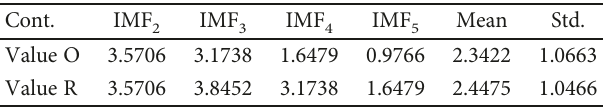
Table 2: The frequency value on the maximum amplitude in each IMF.